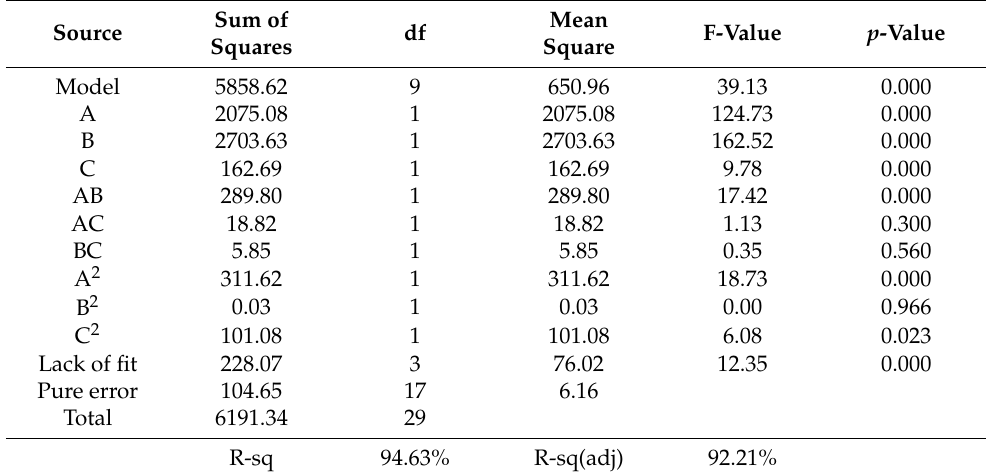
Table 5. Results of ANOVA performed on the ultimate tensile strength results.